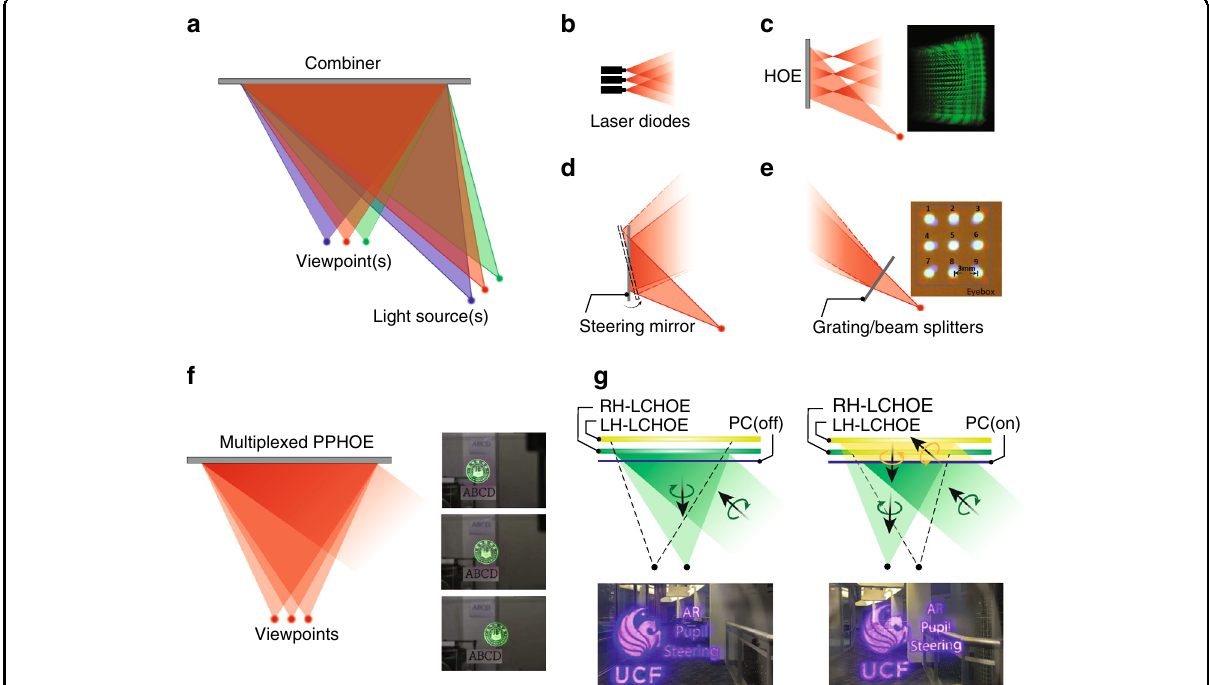
Fig. 10 Methods of pupil duplication and pupil steering. a Schematic of duplicating (or shift) viewpoint by modulation of incident light. Light modulation by b multiple laser diodes, c HOE lens array, d steering mirror and e grating or beam splitters. f Pupil duplication with multiplexed PPHOE. g Pupil steering with LCHOE. Reproduced from c ref. 168 under the Creative Commons Attribution 4.0 License, e ref. 169 with permission from OSA Publishing, f ref. 171 with permission from OSA Publishing and g ref. 173 with permission from OSA